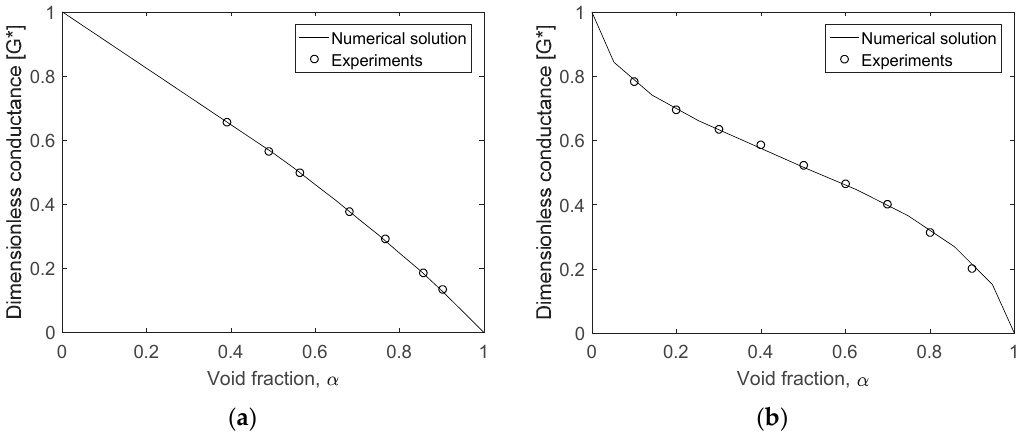
Figure 4. Predicted and measured dimensionless conductance as a function of the void fraction: ( a ) Annular flow; ( b ) Stratified flow.